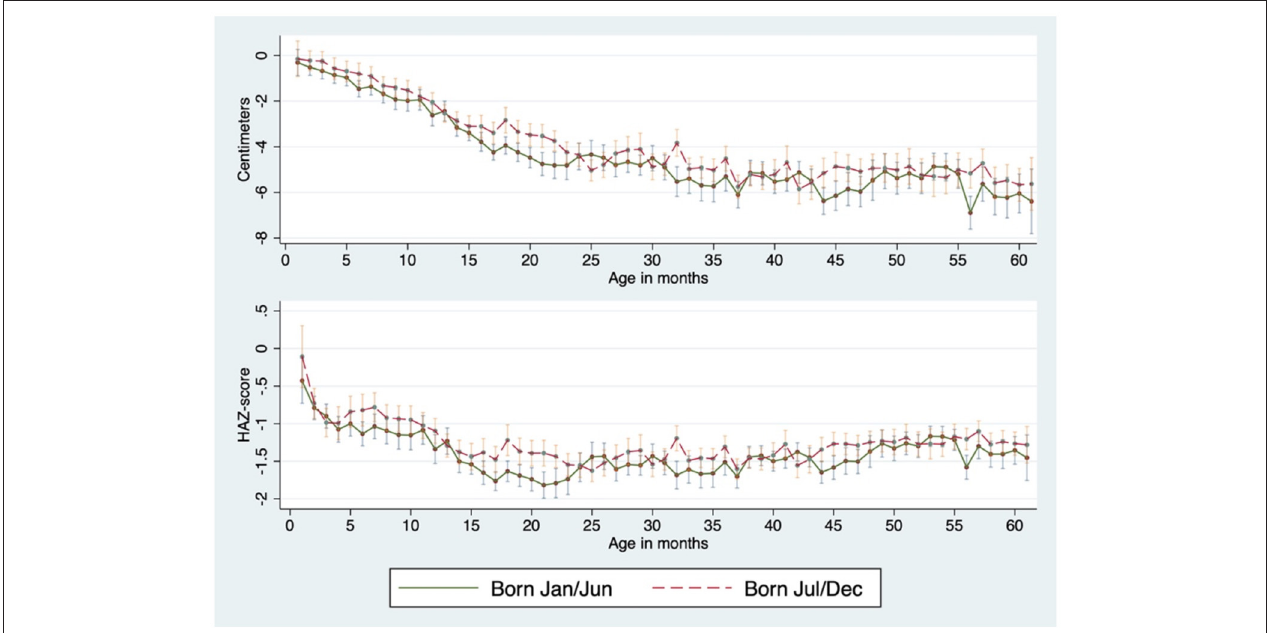
FIGURE 6 | Linear growth faltering in centimeters and height-for-age z-score by birth season in 2019. Source: Own elaboration based on Caritas Venezuela data. 95% confidence intervals.